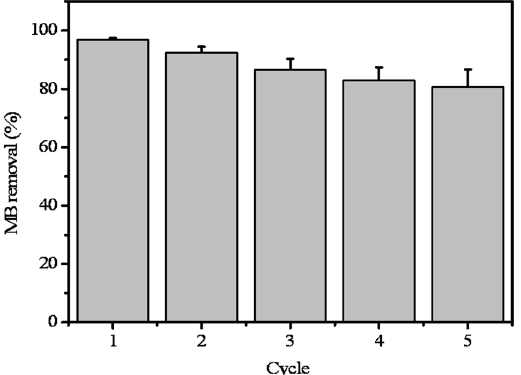
Figure 5. Removal efficiency of MB for different cycles of NH 2 -MIL-88B(Fe) using identical reaction conditions. Reaction conditions: pH 5.6, 0.3 g/L of NH 2 -MIL-88B(Fe), 0.2 M H 2 O 2 , 20 mg/L of MB. Error bars represent one standard deviation ( n =